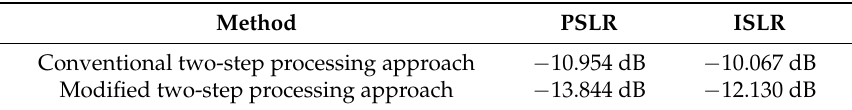
Table 4. Results of a nonstandard point